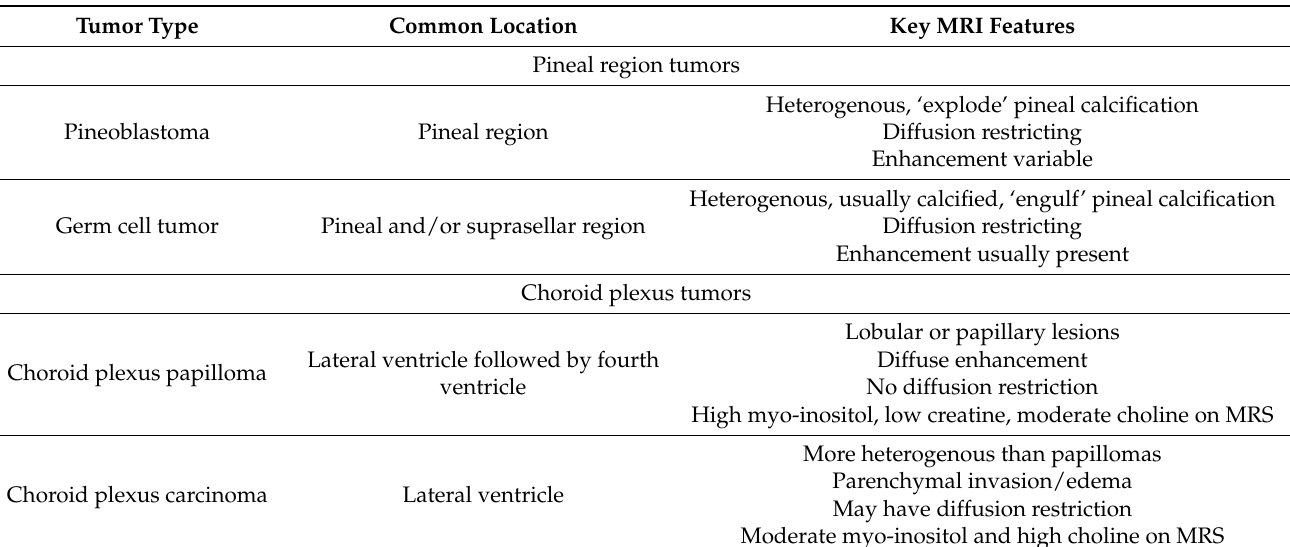
Table 3. Summary of key imaging features of pineal region and choroid plexus